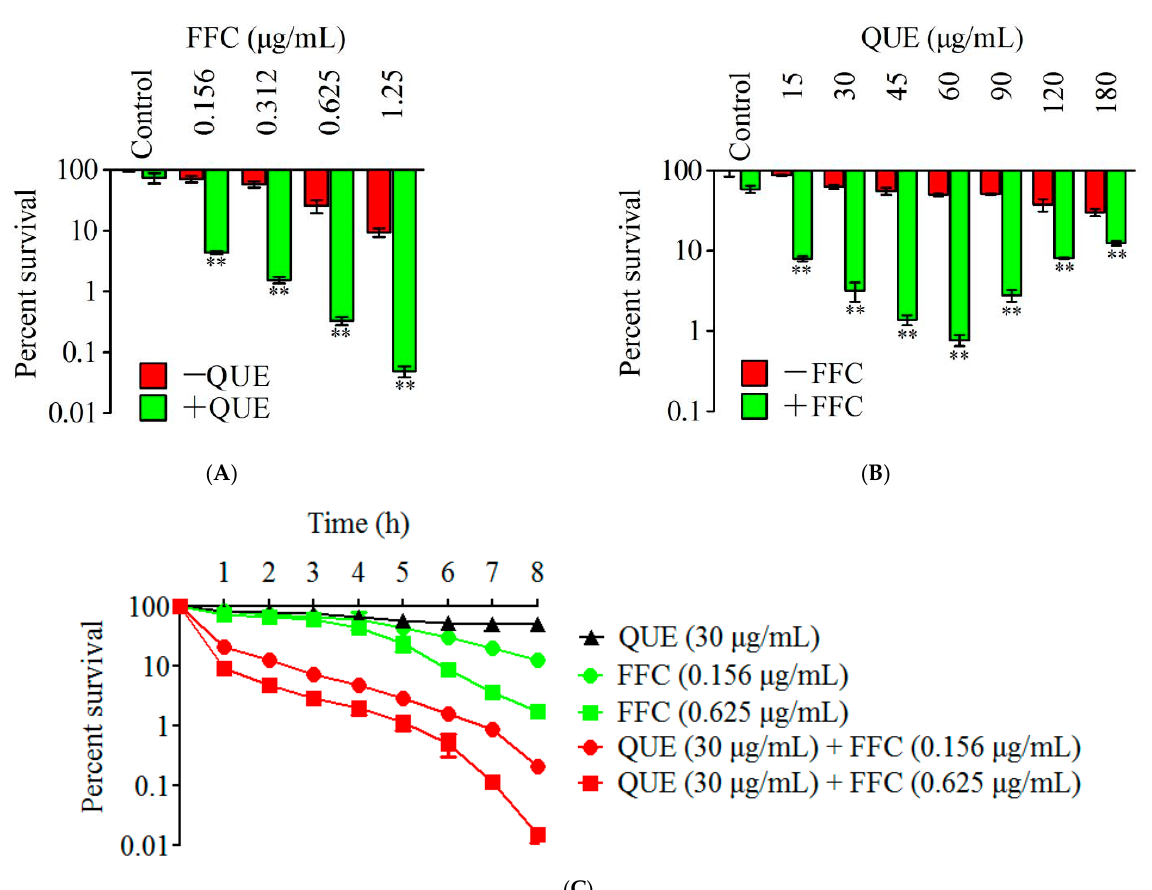
Figure 2. Synergistic bactericidal effect of quercetin and florfenicol against A. hydrophila in vitro . ( A ), The bacterial survival rate of 30 μ g/mL quercetin combined with different concentrations of ( A ), The bacterial survival rate of 30 µ g/mL quercetin combined with different concentrations of florfenicol; ( B ), The bacterial survival rate of 0.156 μ g/mL florfenicol combined with quercetin at florfenicol; ( B ), The bacterial survival rate of 0.156 µ g/mL florfenicol combined with quercetin different concentrations; ( C ), The bacterial survival rate was 0.156 μ g/mL or 0.625 μ g/mL of at different concentrations; ( C ), The bacterial survival rate was 0.156 µ g/mL or 0.625 µ g/mL of florfenicol combined with 30 μ g/mL quercetin. QUE, quercetin; FFC, florfenicol. ** p < 0.01. florfenicol combined with 30 µ g/mL quercetin. QUE, quercetin; FFC, florfenicol. ** p <